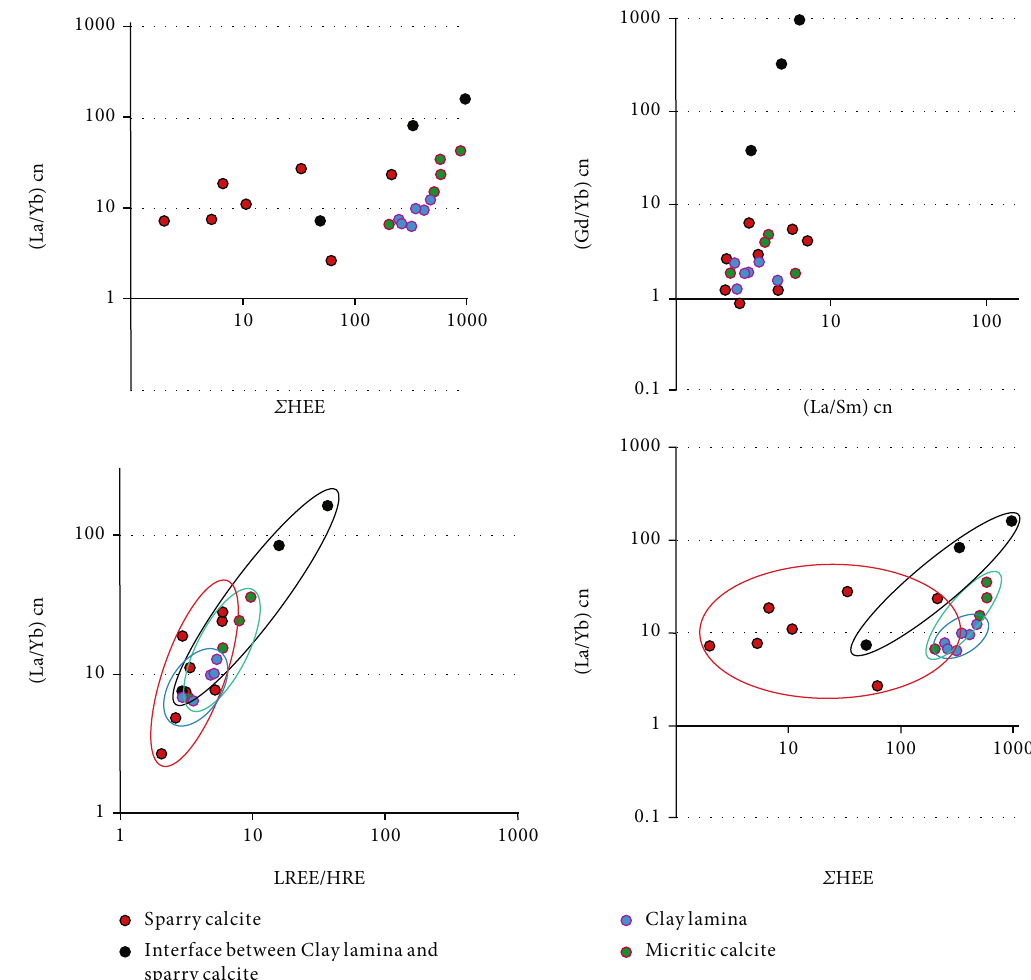
Figure 9: LREE/HREE- ð La/Yb Þ